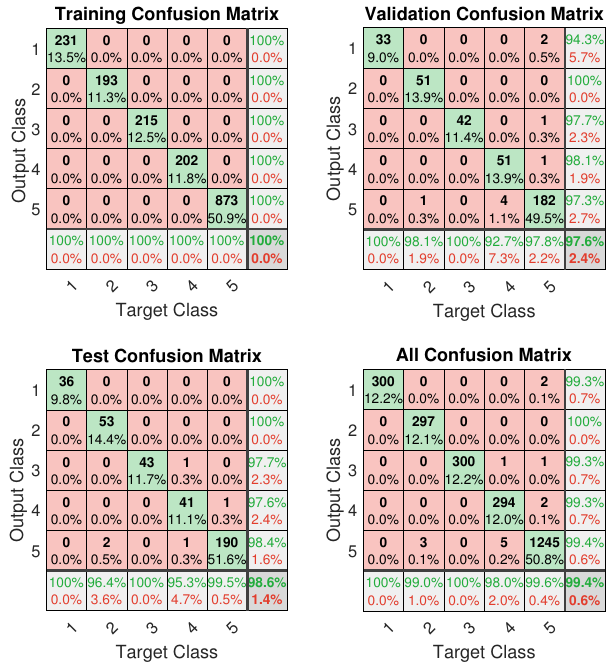
Figure 11. Confusion matrix of the designed